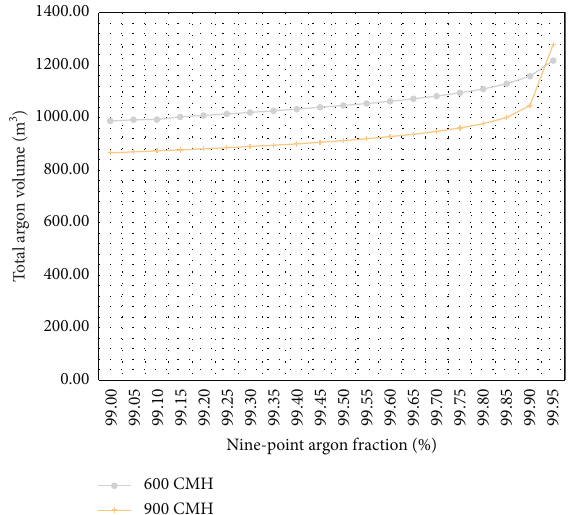
Figure 14: Total argon volume to achieve the nine-point argon fraction (see Figure 11).